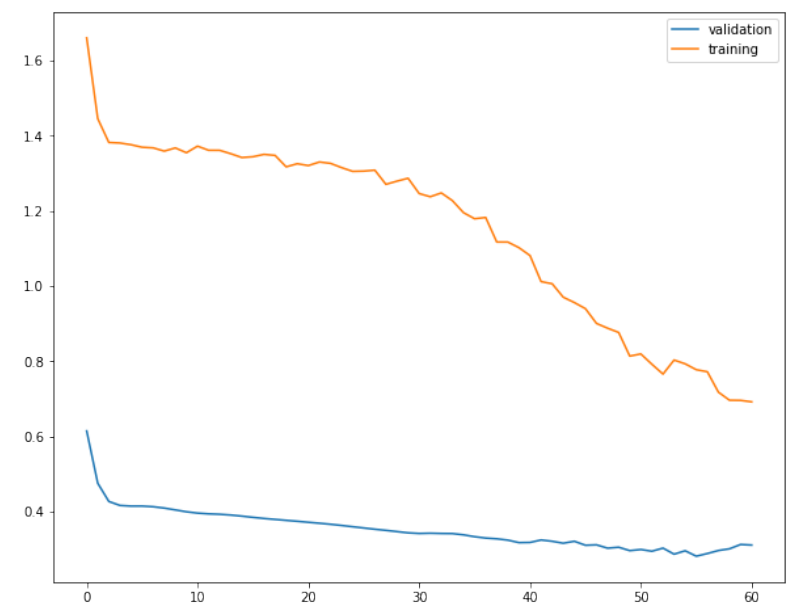
Figure 8. Trajectory of training and validation losses, as a function of the training epoch, for product 1. Please note that the cost functions are calculated on rescaled data, therefore they cannot be directly compared to the values appearing on the first line of Table 8.